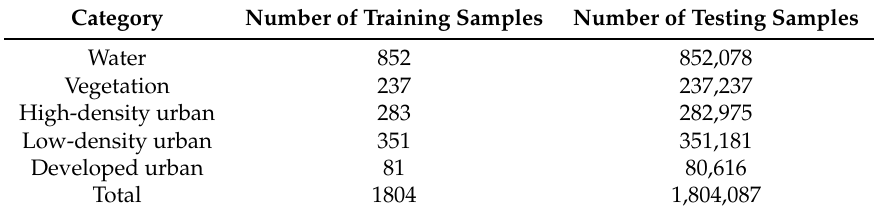
Table 4. Number of samples for San Francisco Bay